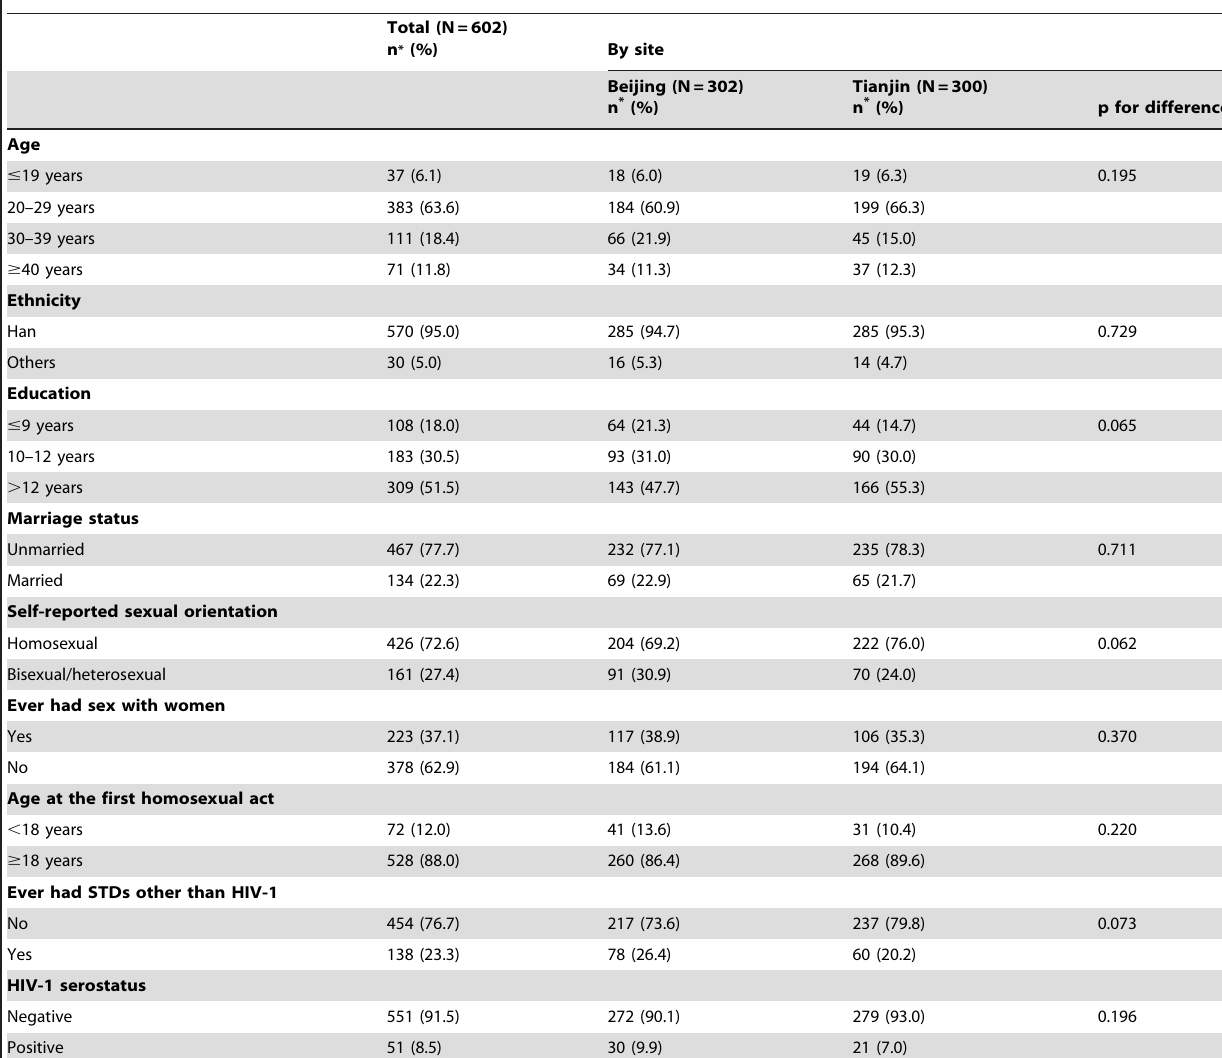
Table 1. Characteristics of the study population by study